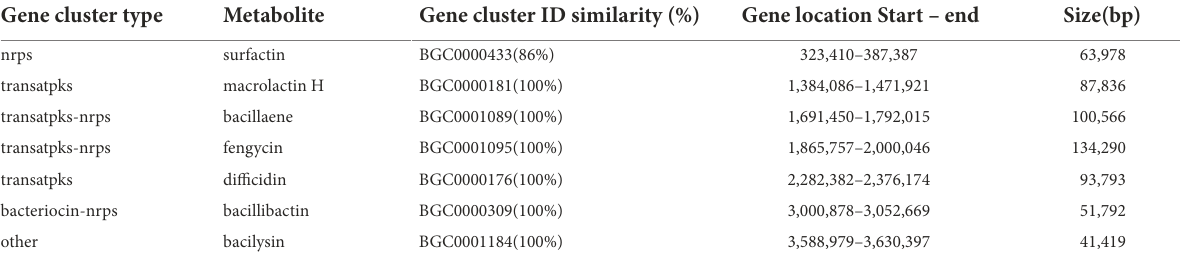
TABLE 4 Biosynthetic gene clusters of secondary metabolite in strain of SDTB038 genome. Gene cluster